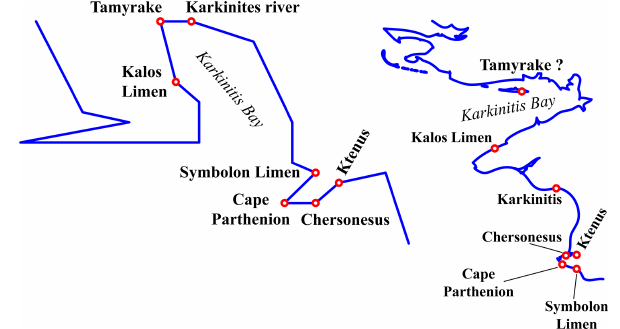
Figure 9. The points of the western Crimea on Ptolemy’s map and on the modern